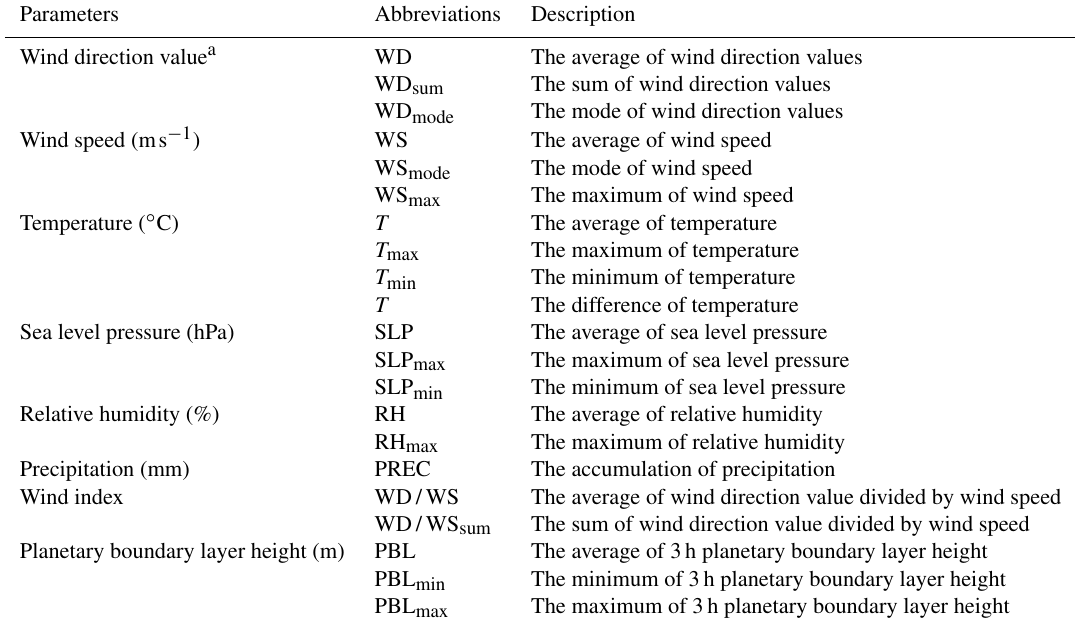
Table 3. Meteorological parameters used in the GLM in this study. The calculation of each meteorological parameter is based on the sample duration of 23.5h (09:30–09:00LT the next